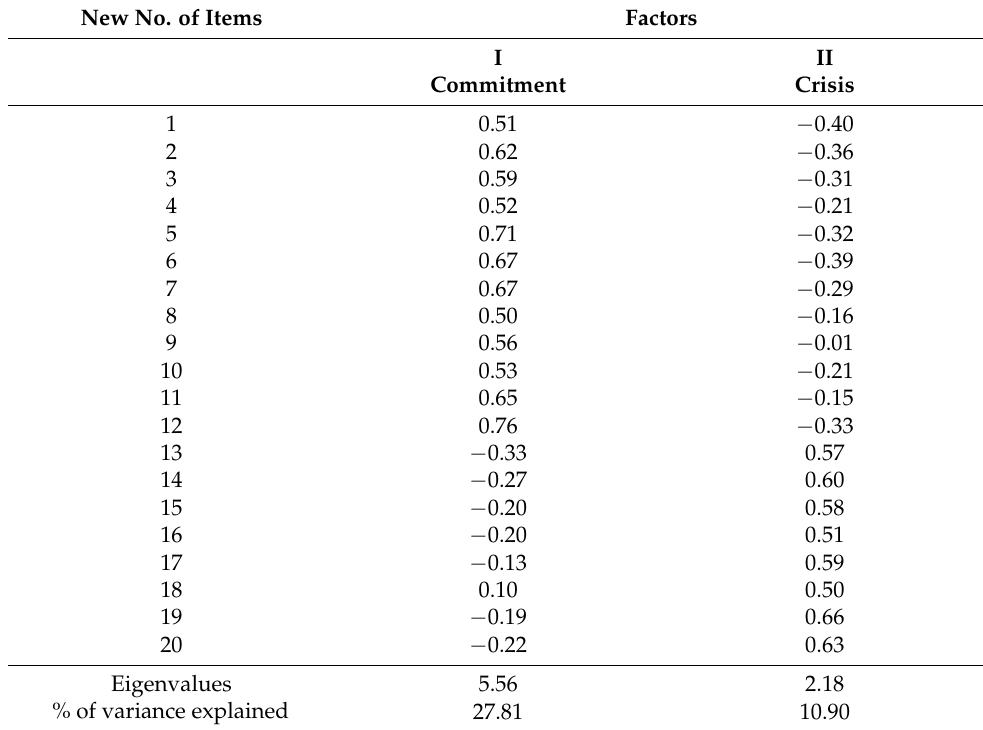
Table 1. Factor loading of 20 items of Institutional Identity Scale for University Students for two factors in factor solution obtained through Oblique rotation ( N = 707). New No. of Items